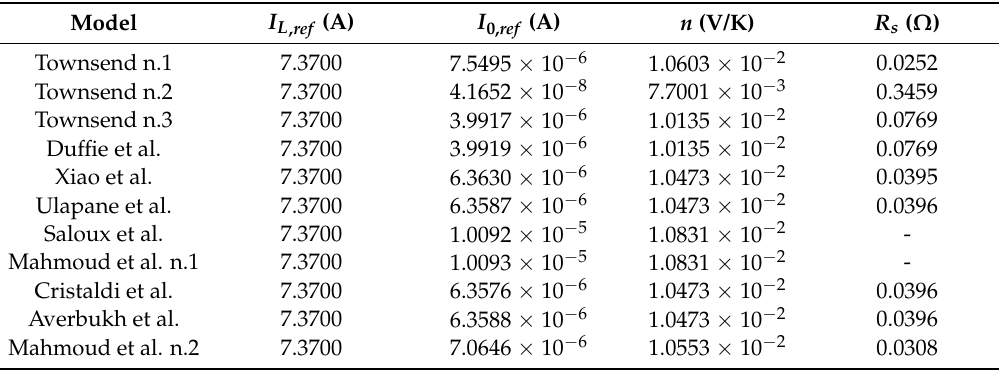
Table 4. Model parameters of the Sanyo HIT-240 HDE4 at the